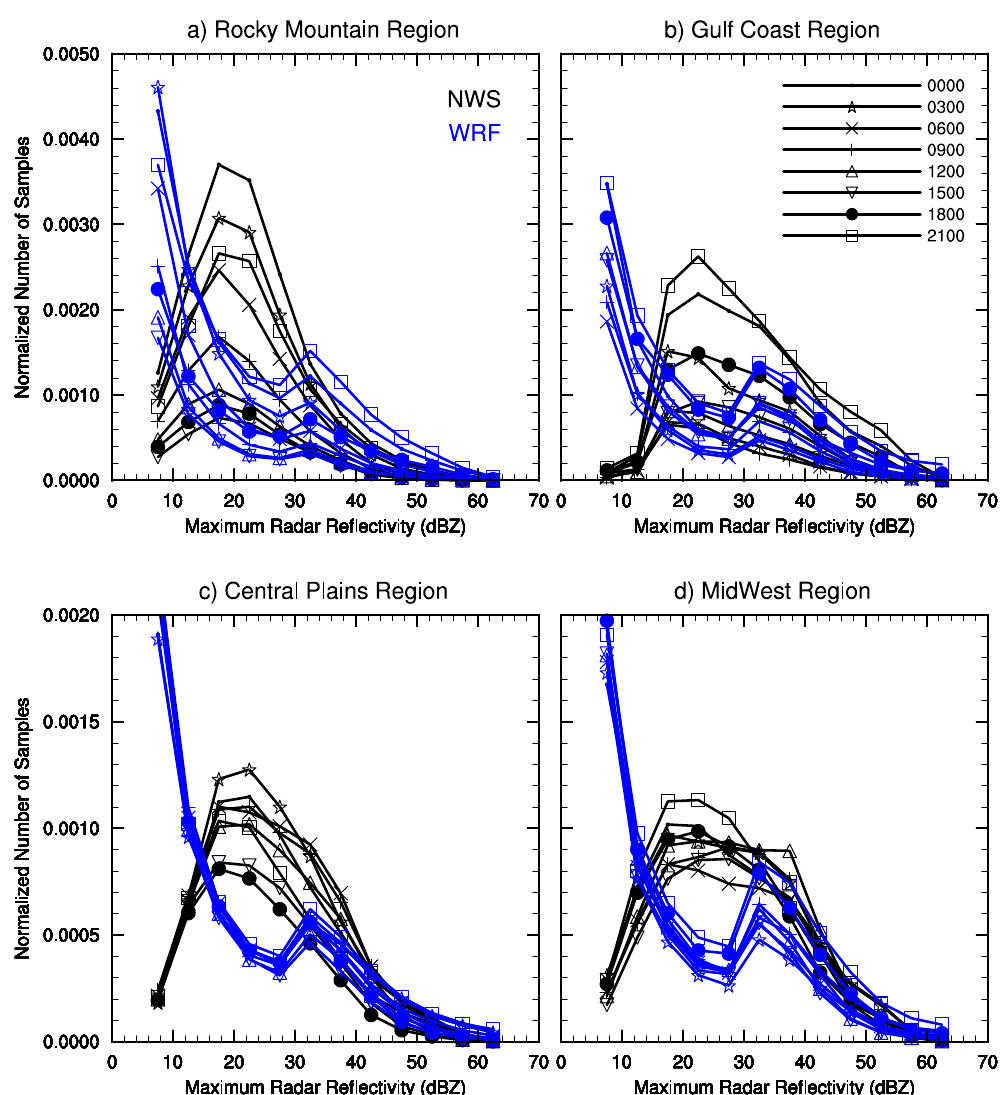
Fig. 4. Frequency distribution of radar reflectivity from observations (black lines) and model results (blue lines) at different hours of the day (see legend; time is UTC) for the 15 July to 6 August period. (a) Rocky Mountain region, (b) Gulf Coast region, (c) Central Plains region, and (d) Midwest region as shown in Fig.